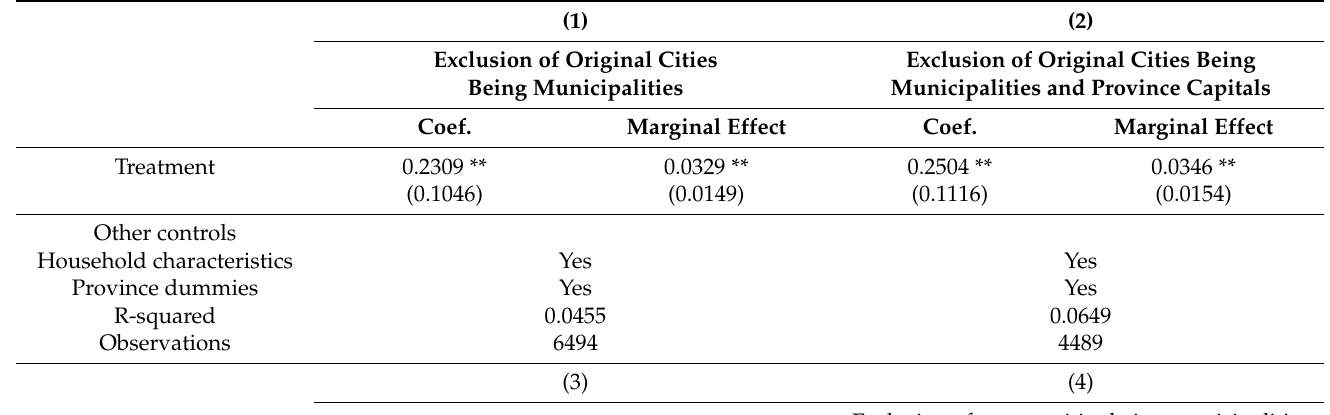
Table 3. Robustness checks: excluding the effects of large